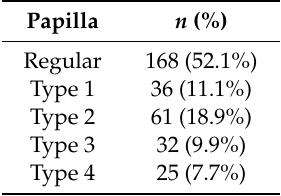
Table 1. Distribution of the di ff erent endoscopic aspects of the